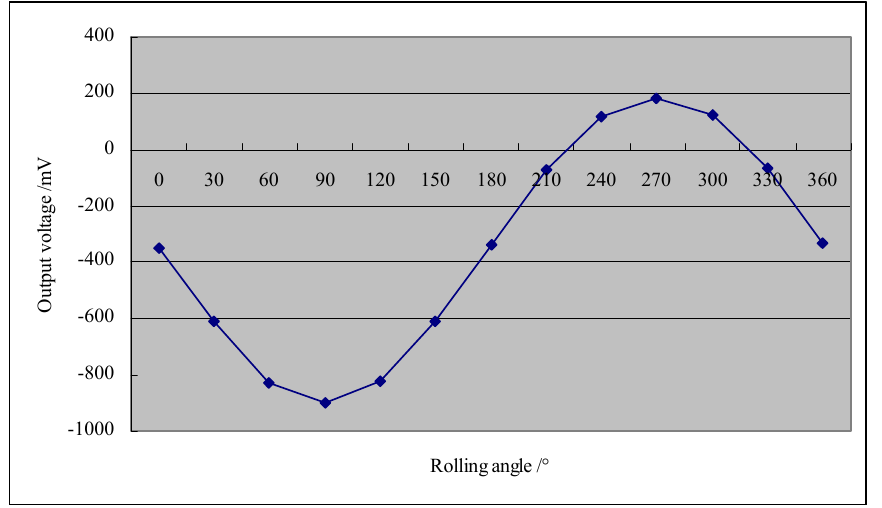
Figure 12. Output curve of static rolling experiment in ±1g gravitational